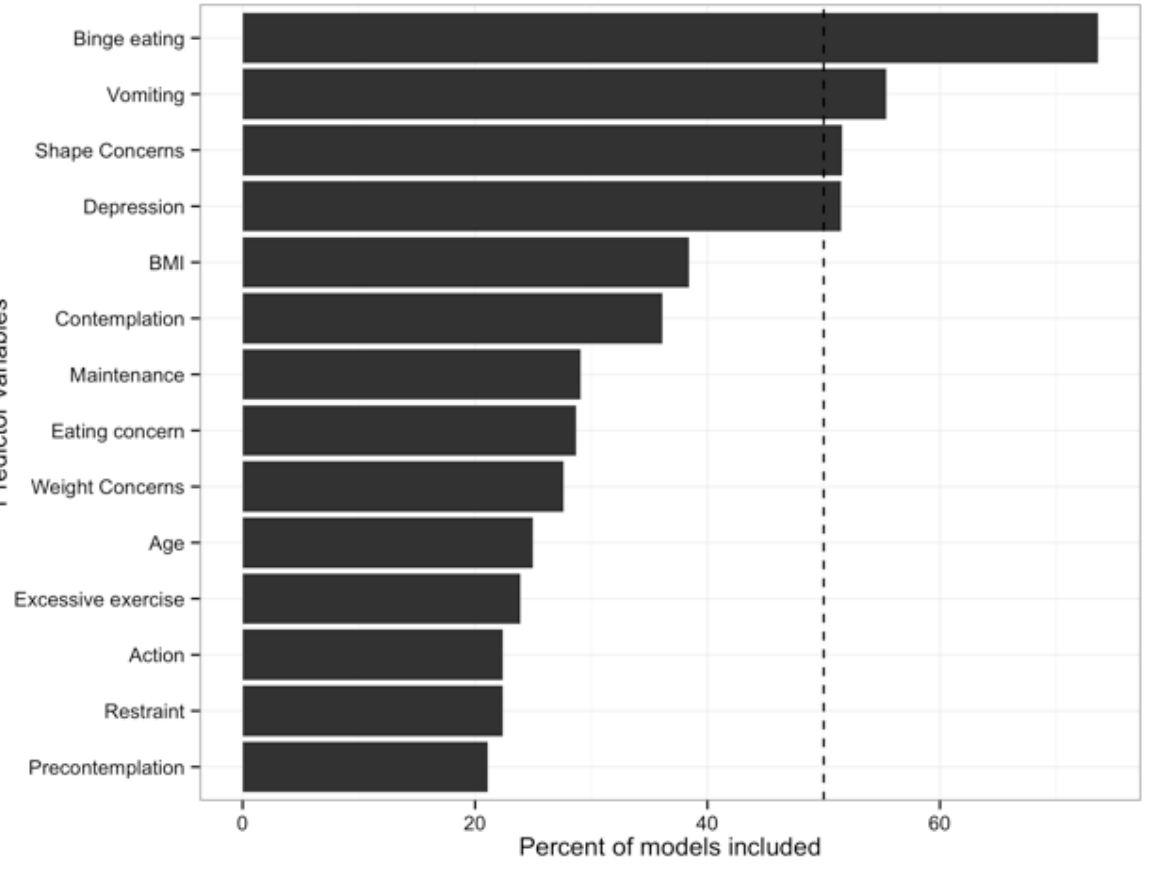
Figure 3. Number of pseudosamples for which the LASSO identified the variables as